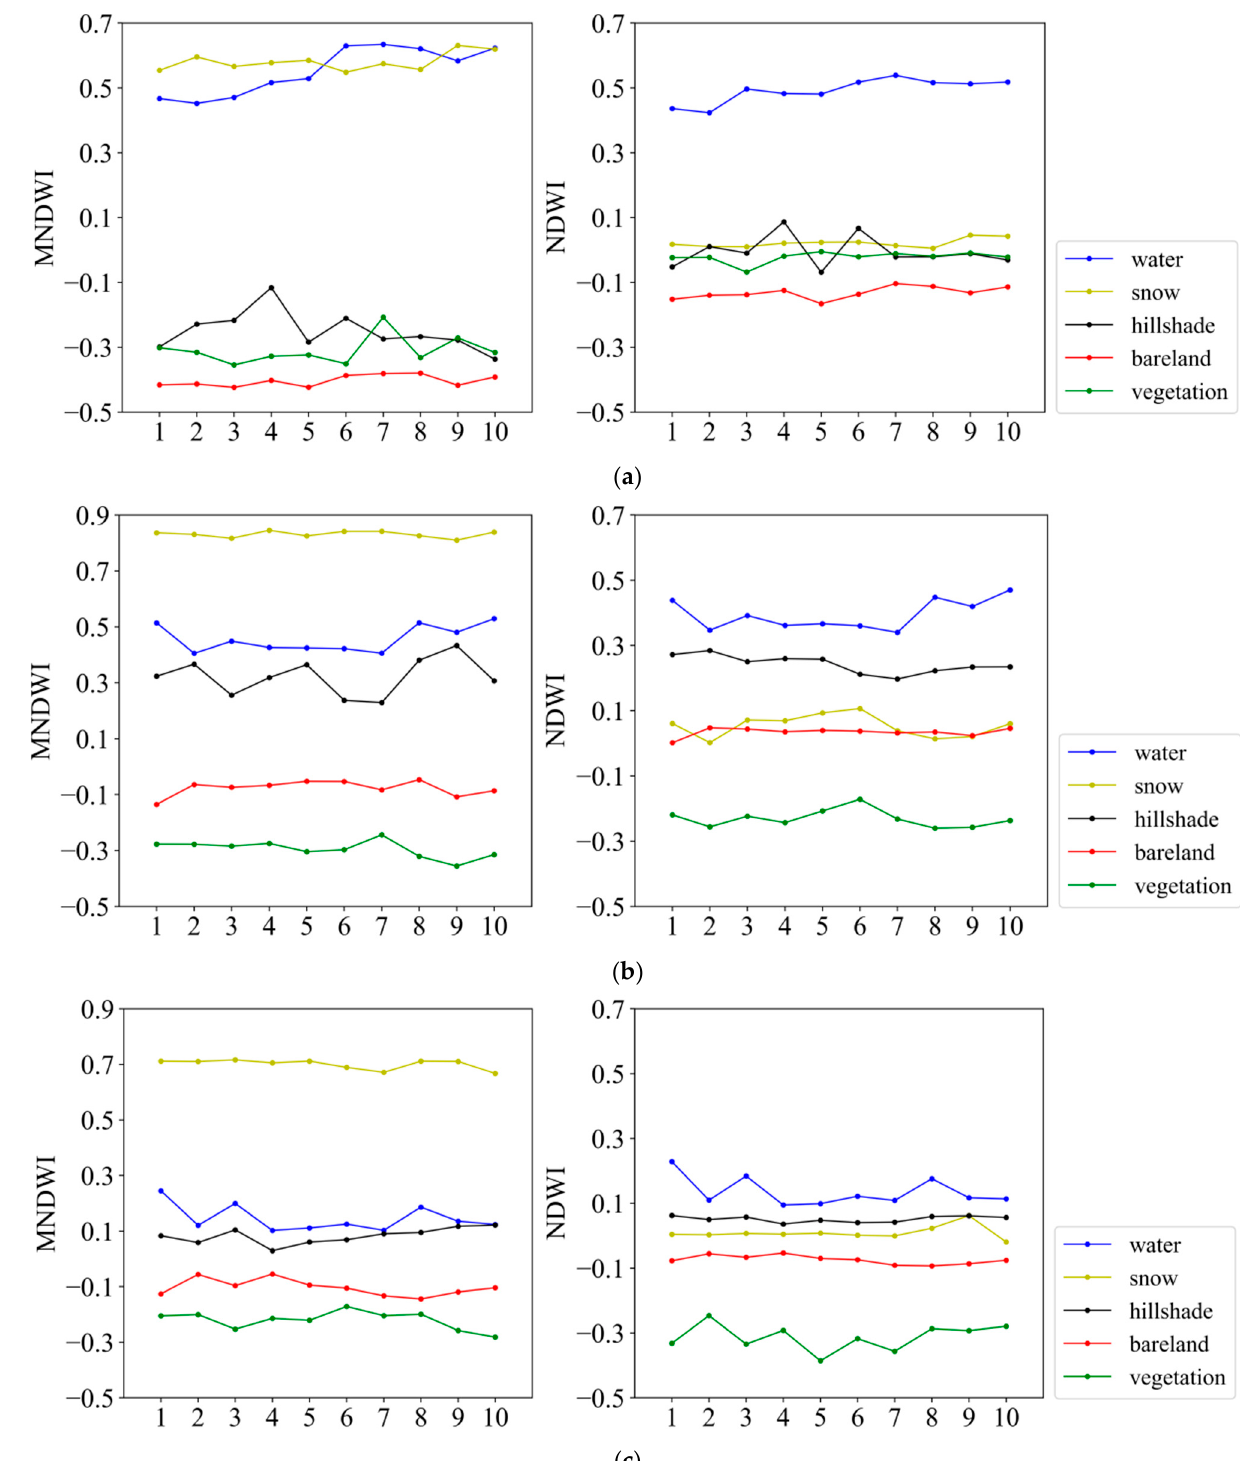
Figure 5. Line graphs of water indexes of different surface features: ( a ) MNDWI and NDWI of different surface features of Landsat TM; ( b ) MNDWI and NDWI of different surface features of Landsat ETM+; ( c ) MNDWI and NDWI of different surface features of Landsat OLI.